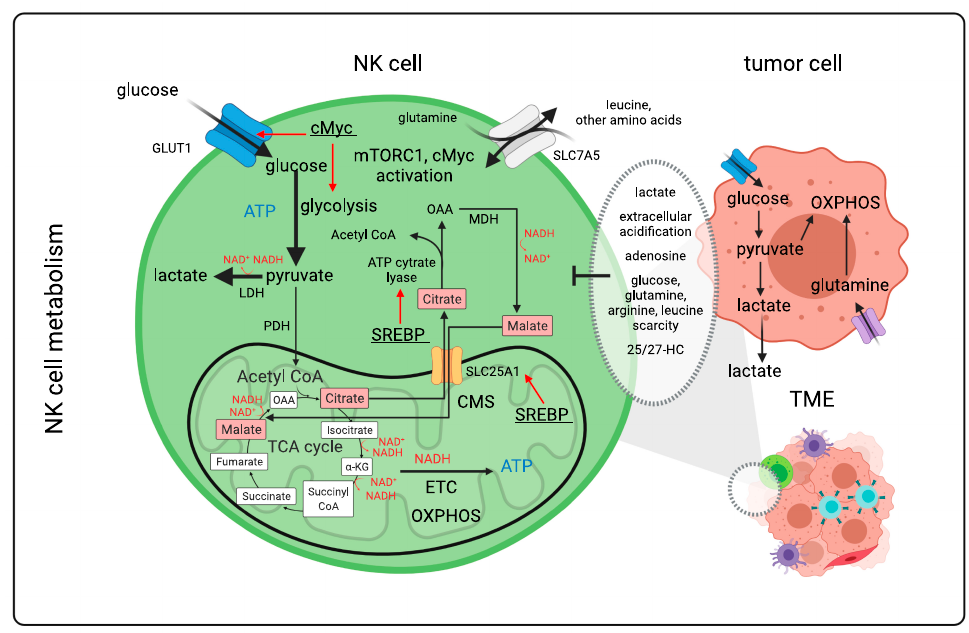
Figure 5. NK cell metabolism upon activation and challenges within the TME. NK cells rely on glucose to sustain glycolysis and OXPHOS for the production of energy. The citrate–malate shuttle between mitochondrial citrate and cytosolic malate provides sufficient reducing equivalents in the cytoplasm to sustain glycolysis and glycolytic ATP production while generating lactate. The citrate– malate shuttle also generates NADH molecules in the mitochondria apart from the ones that are generated by the tricarboxylic acid during OXPHOS. NADH molecules are oxidized by the electron transport chain to produce ATP. Upon NK cell activation, SREBPs transcriptionally controls the expression of the malate–citrate antiporter SLC25A1 and the ATP citrate lyase. In activated NK cells, the glucose transporter Glut1 is upregulated as well as the aa transporter SLC7A5. The exchange of intracellular glutamine for other aa, such as leucine through SLC7A5, increases the intracellular aa availability that is required to activate mTORC1 and enhance cMyc expression. cMyc transcriptionally controls glycolysis as well as the expression of the glucose transporter GLUT1. NK cells at the synapse with tumor cells and within the tumor microenvironment encounter extracellular acidification. This is mediated by a higher content of lactate secreted by tumor cells, inhibitory metabolites such as adenosine, limited availability of glucose and aa such as glutamine, arginine and leucine, as well as soluble inhibitors of SREBPs such as 25/27-HC. LDH, lactate dehydrogenase; PHD, pyruvate dehydrogenase; TCA, tricarboxylic acid; OAA, oxalacetate; α -KG, α -ketoglutarate; ETC, electron transport chain; OXPHOS, oxidative phosphorylation; CMS, citrate–malate shuttle; SREBPs, sterol regulatory element-binding proteins; mTORC1, mammalian target of rapamycin complex 1; MDH, malate dehydrogenase; 25/27-HC, hydroxycholesterol; TME, tumor microenvironment. aa, amino acid. Figure generated by Biorender.com (accessed on 15 November